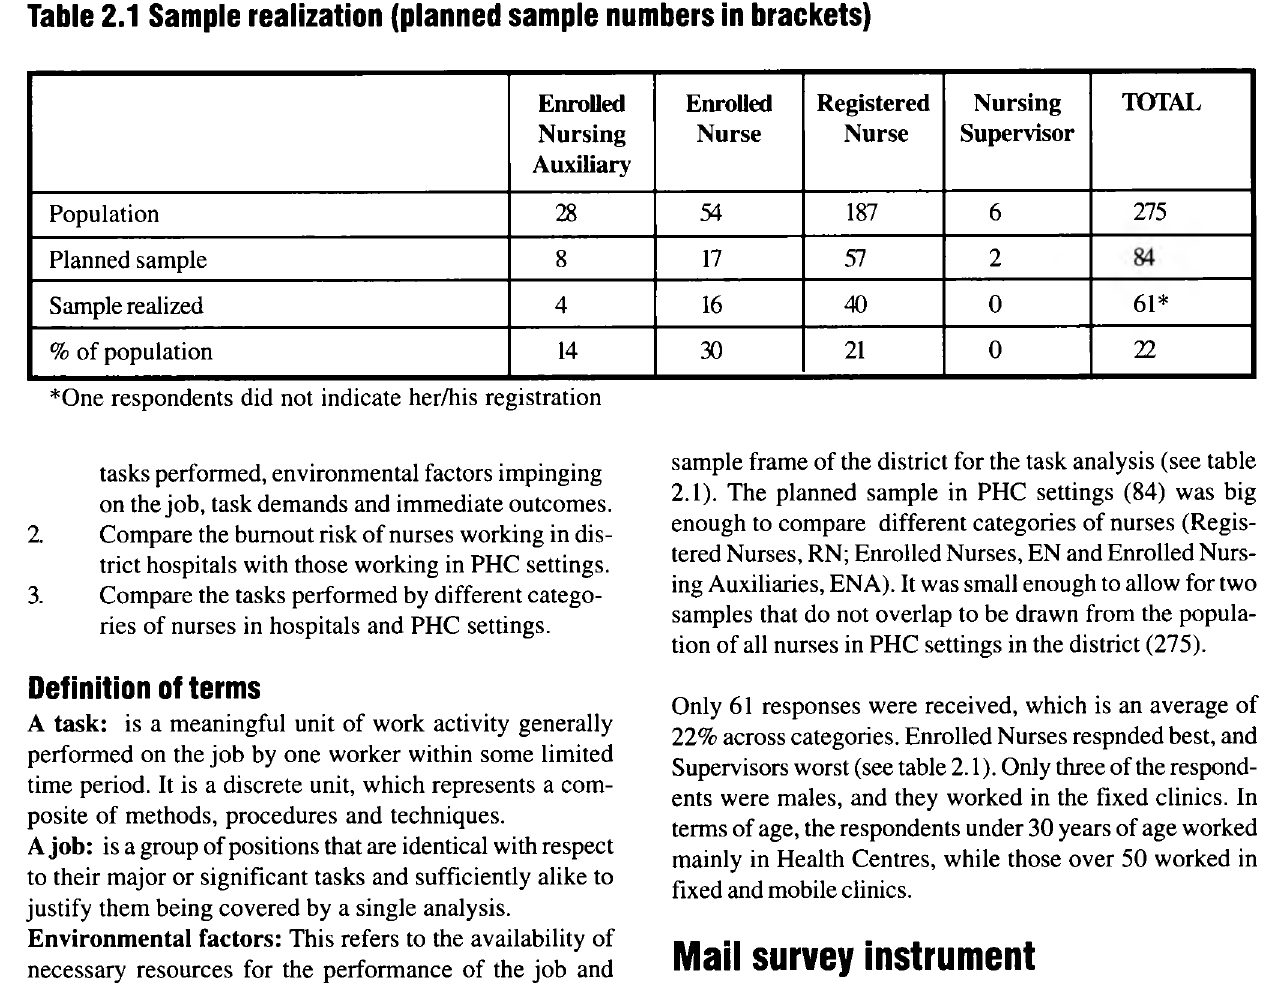
Table 2.1 Sample realization (planned sample numbers in